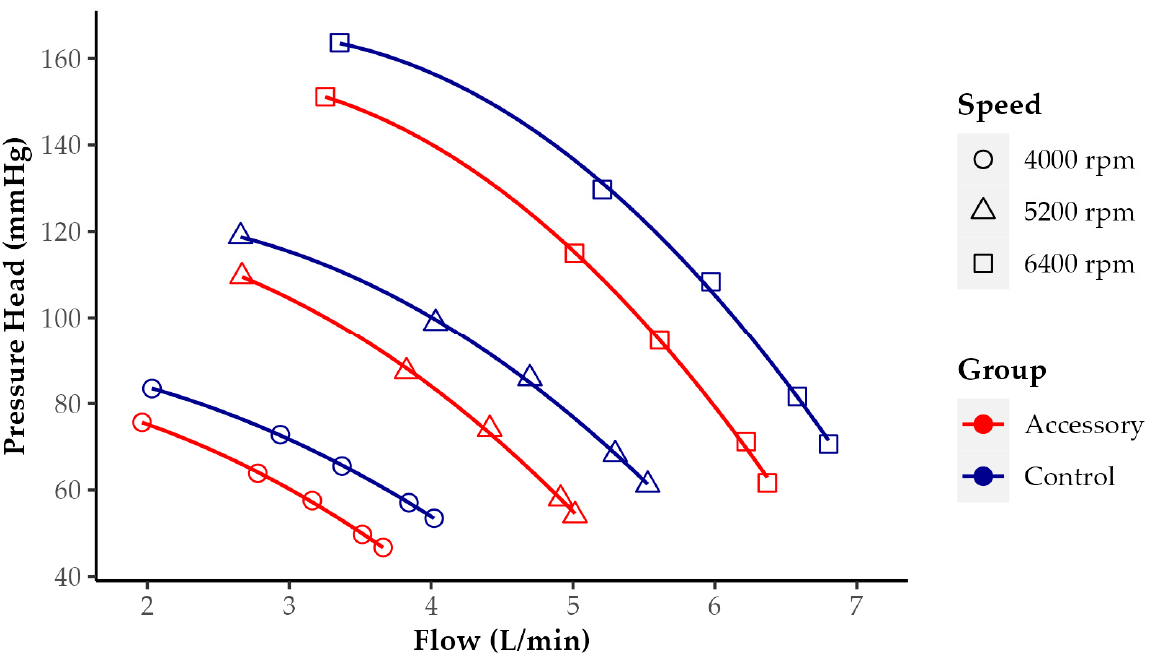
Figure 3. Pressure head versus flow (HQ) curves of HeartMate 3 with and without LVAD accessory at 3 rotational speeds (4000, 5200, and 6400 rpm). Each point in the diagram represents flow and pressure head at one resistance level (at same speed highest flow at lowest resistance). A change in pressure head in the Control group, for example, at 5200 rpm from 100 to 60 mmHg, led to nearly the same change in measured flow as in the Accessory